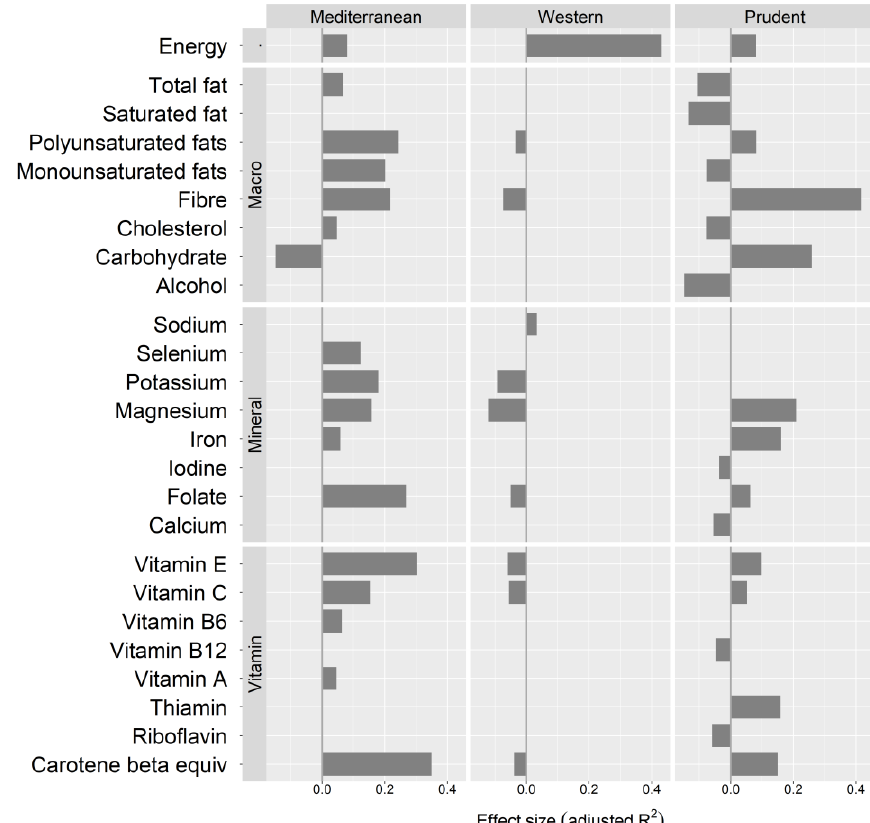
Figure 1. The plot shows the effect size of correlations between nutrients and each dietary pattern i.e., linear change as dietary pattern scores increase. Nutrients are adjusted for energy intake using the residual method [29]. Bars to the right of zero show a positive nutrient intake correlation to dietary pattern scores, and bars to the left show a negative nutrient intake correlation to dietary pattern scores. The size of the bar shows the magnitude of the effect (adjusted R 2 ). All nutrients shown are significant after Bonferroni adjustment (adjusted p -value < 0.05). Protein, sugar, zinc, phosphorus, retinol, niacin, and niacin equivalent were analysed but showed no associations.